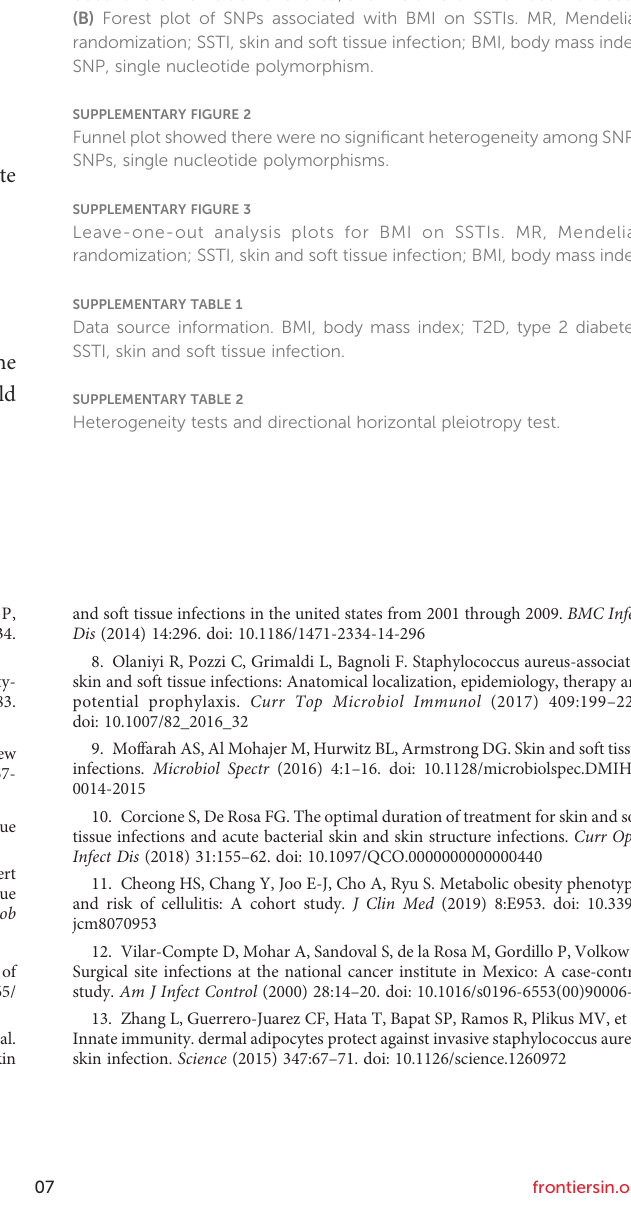
(A) Scatter plot of SNPs showing the causal effect of BMI on SSTIs. The log odds ratio of risk is demonstrated, and fi ve different methods were used. (B) Forest plot of SNPs associated with BMI on SSTIs. MR, Mendelian randomization; SSTI, skin and soft tissue infection; BMI, body mass index; SNP, single nucleotide polymorphism.